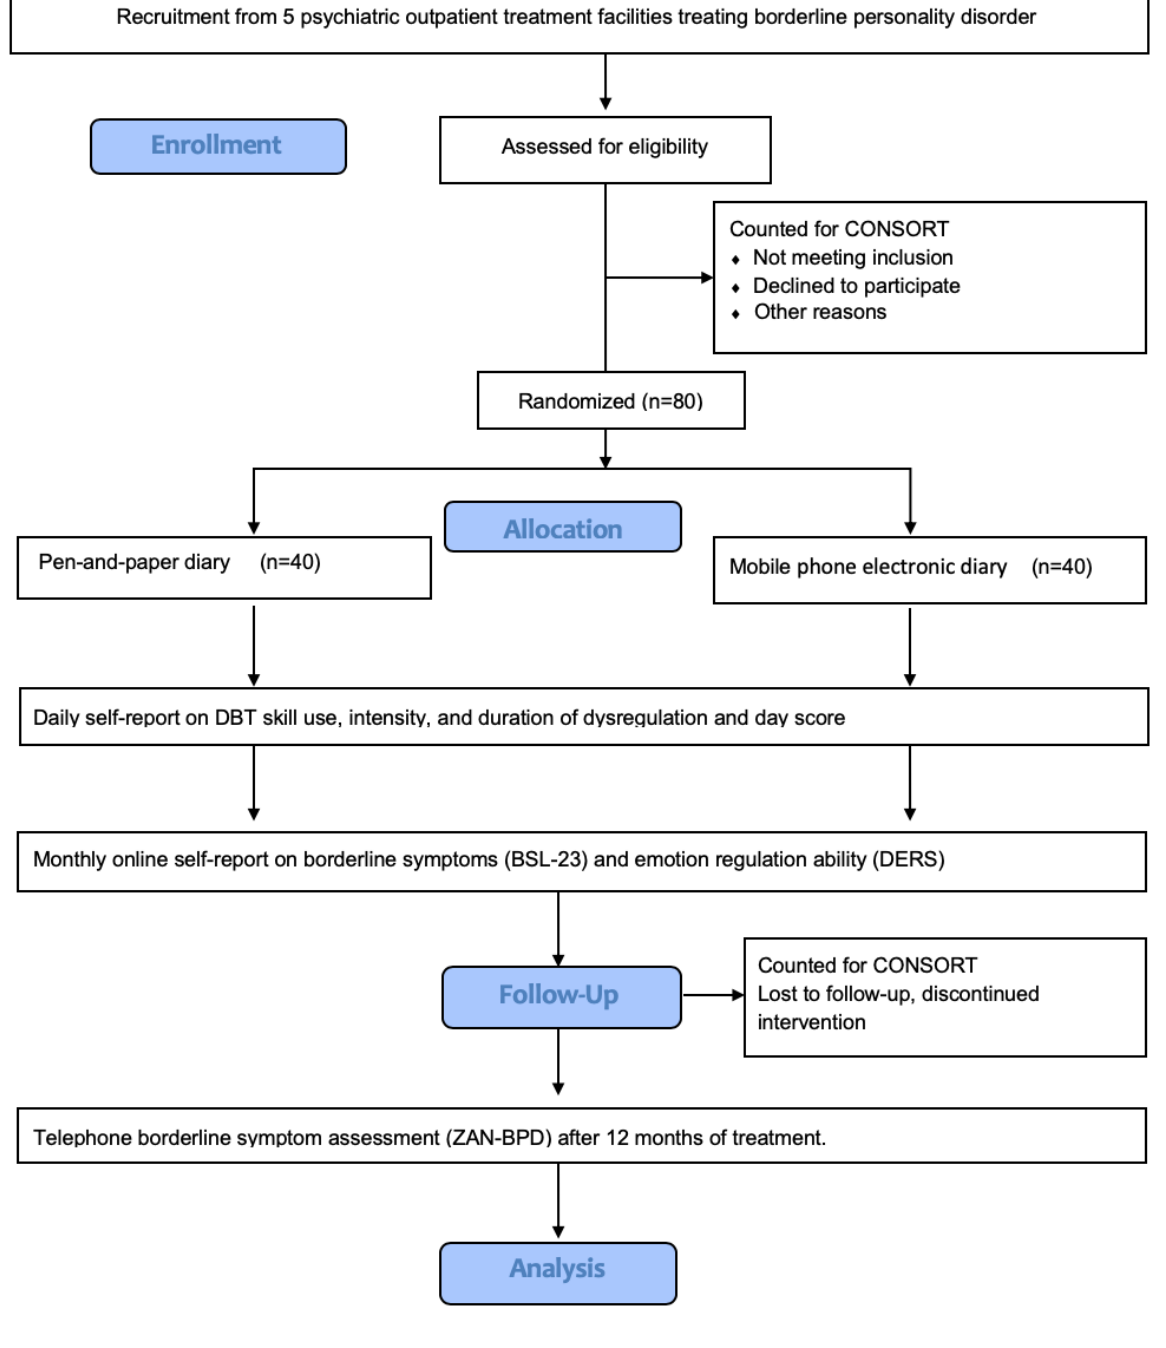
Figure 1. CONSORT (Consolidated Standards of Reporting Trials) flowchart. DBT: dialectical behavioral therapy; DERS: Difficulties in Emotion Regulation Scale; BSL-23: Borderline Symptom List; ZAN-BPD: Zanarini Rating Scale for Borderline Personality